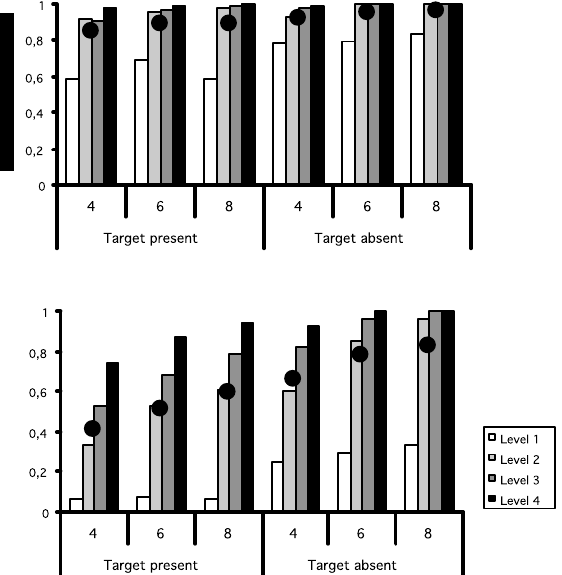
Figure A1. Relative frequencies of trials with more than one saccade (left panel) and more than two saccades (right panel). Relative frequencies were related to remain- ing trials (without errors and without initial fixations out- side center. Black points show average frequencies within one set size.